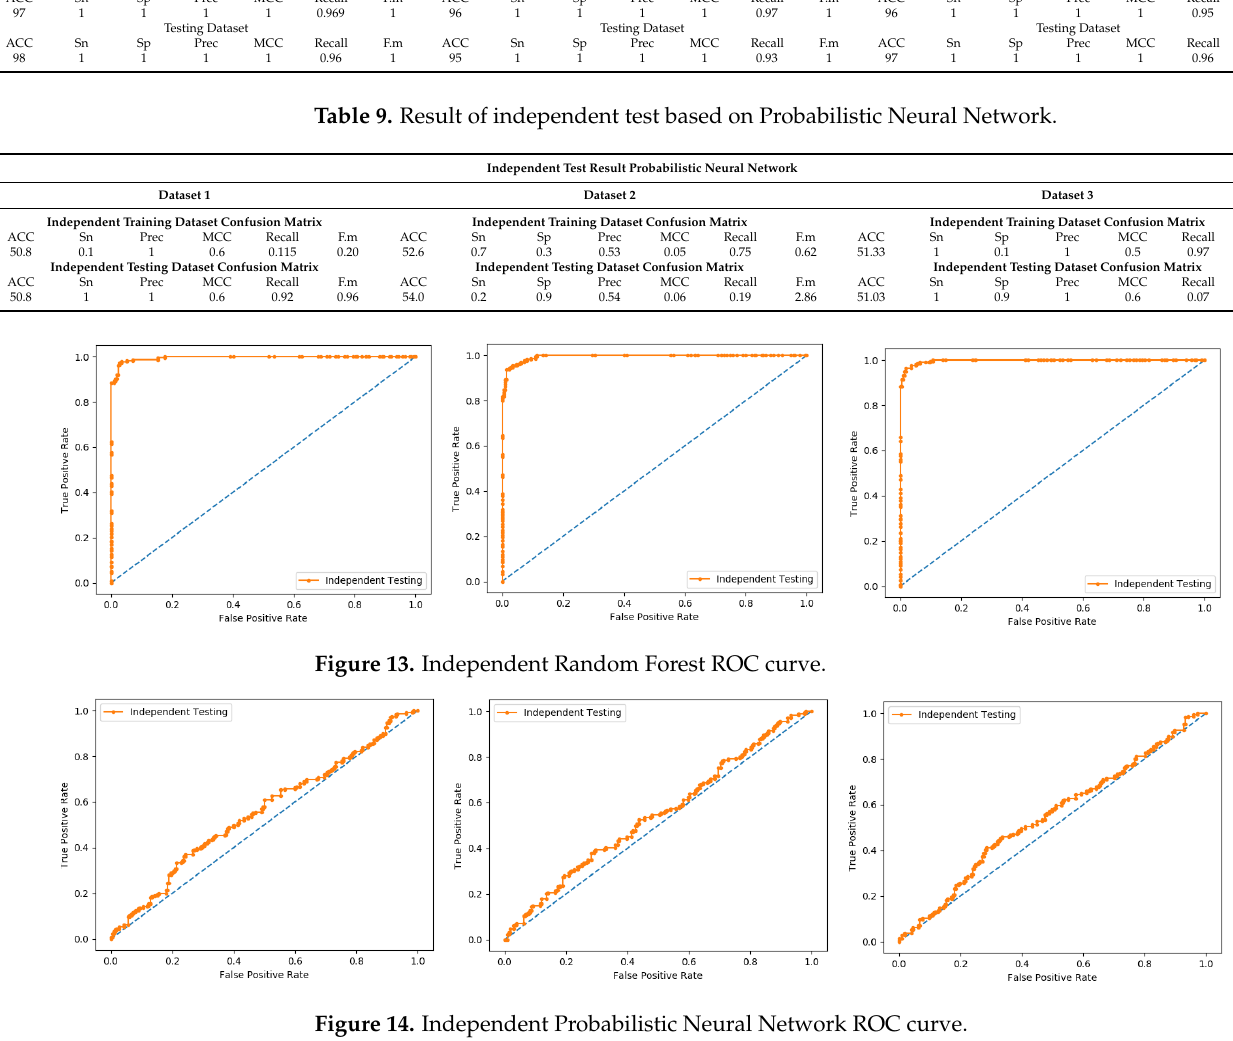
Figure 12. Independent test. Table 8. Results of independent test based on the Random Forest.